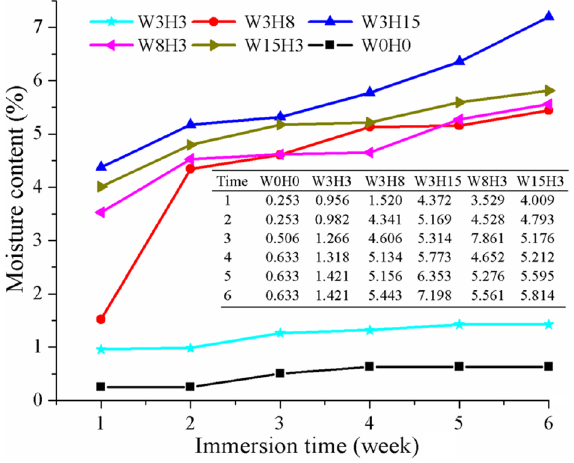
Figure 7. The moisture content of PLA/WS/HA composites as a function of soaking time in water. * Data of W0H0 was refered from our previous work 43